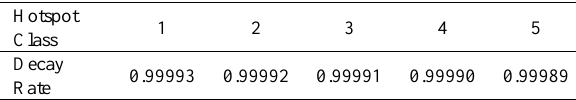
Table 5. Decay rate for different hotspot